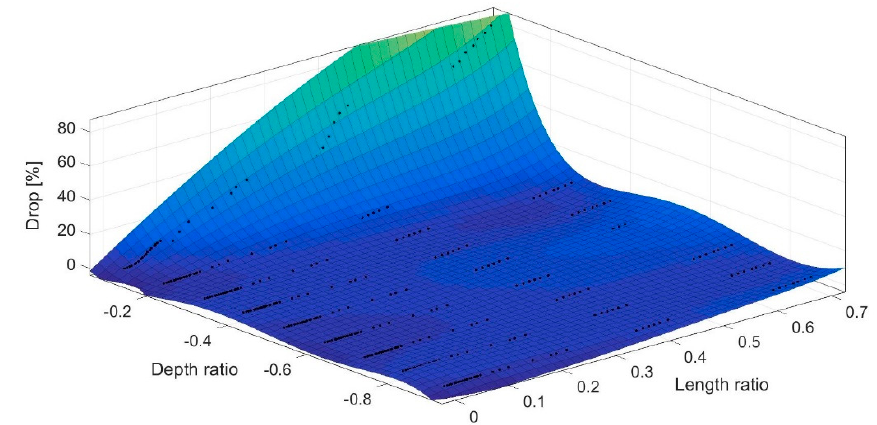
of maximum drop while Figure 6 shows the 3D plot of span vs.